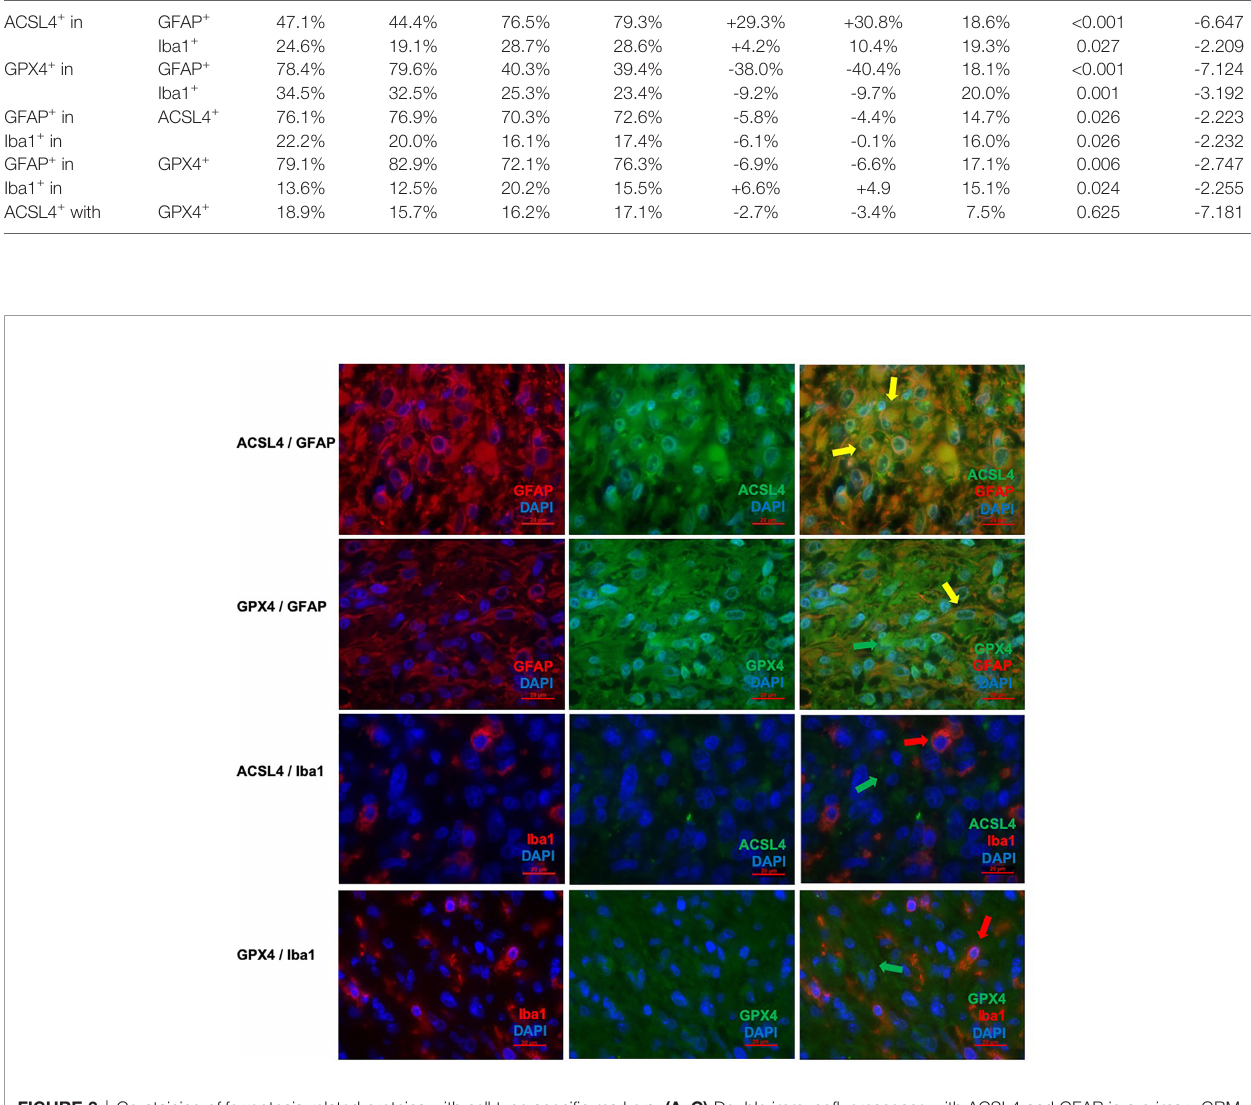
FIGURE 3 | Co-staining of ferroptosis-related proteins with cell type speci fi c markers. (A – C) Double immuno fl uorescence with ACSL4 and GFAP in a primary GBM shows several cells with co-expression (yellow arrow). (D – F) Double immuno fl uorescence with GPX4 and GFAP shows co-expression in many cells in a primary GBM (yellow arrow). Additionally, one cell expressing only GPX4 (green arrow) is marked. (G – I) Double immuno fl uorescence with ACSL4 and Iba1 in a primary GBM shows several Iba1 + cells which mostly do not express ACSL4 (red arrow: Iba1-positive cell lacking ACSL4 expression; green arrow: ACSL4-positive non-microglial cell). (J – L) Double immuno fl uorescence with GPX4 and Iba1 in a relapse GBM. Most cells express either GPX4 (green arrow) or Iba1 (red arrow). Scale bars all 20 m